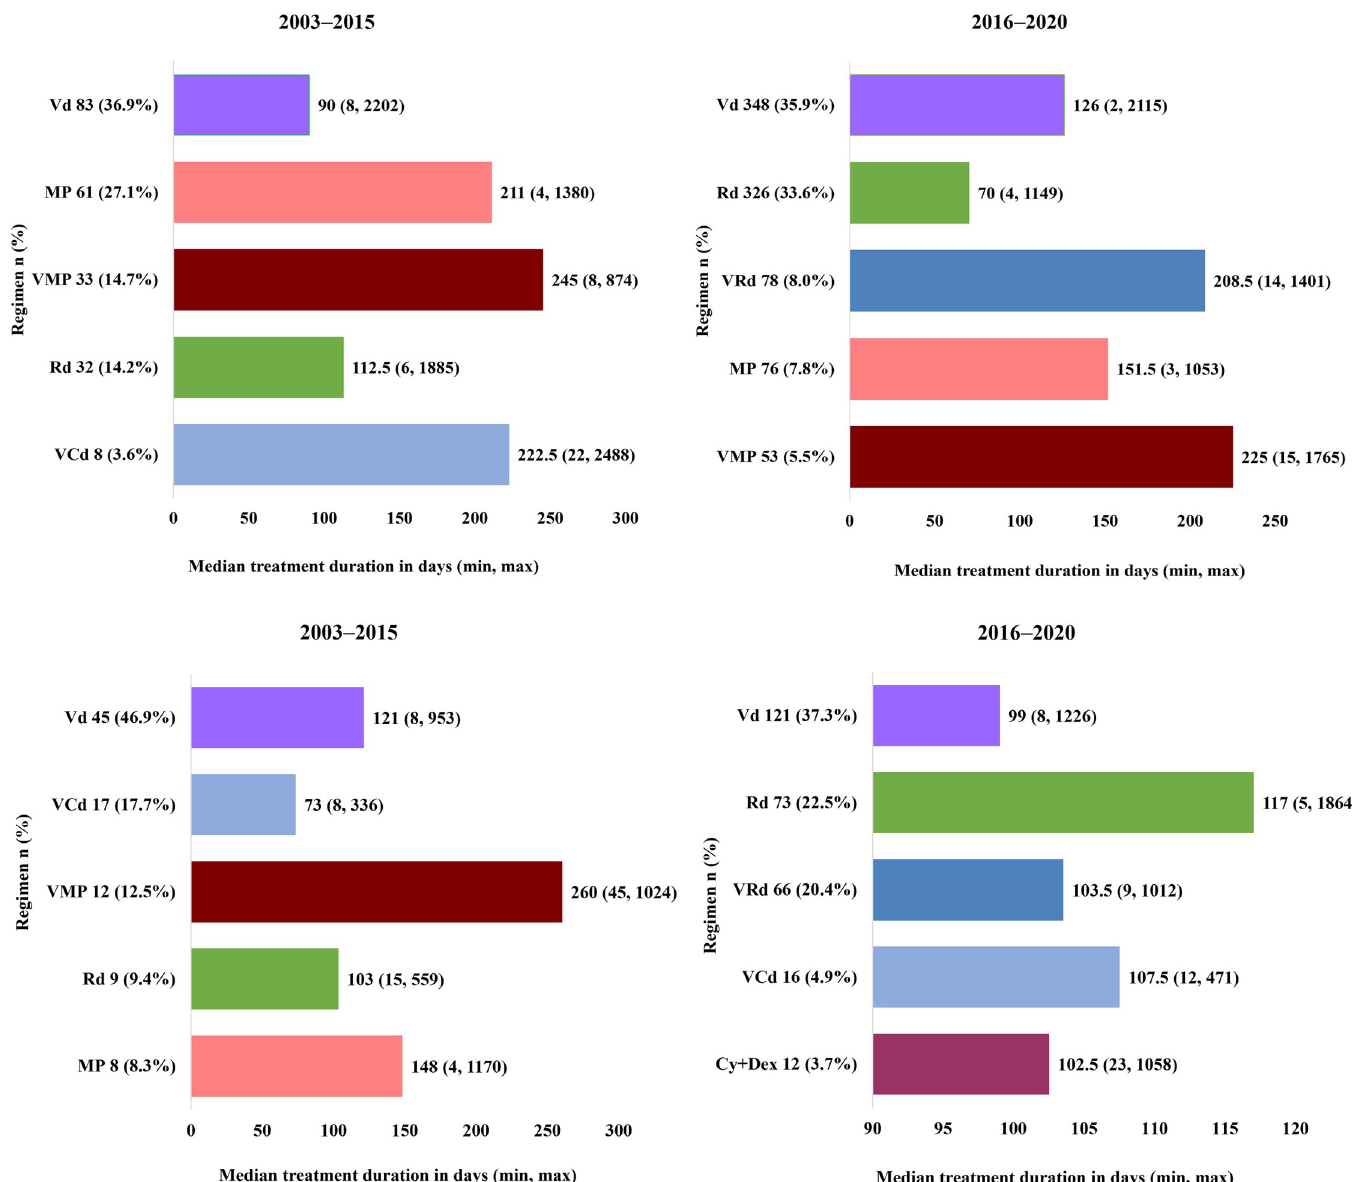
Fig 4. A : First-line treatment duration by selected regimen in SCT not-conducted group (aged > 70 years). B : First-line treatment duration by selected regimen in SCT not-conducted group (aged � 70 years). Cy+Dex, cyclophosphamide/dexamethasone; MP, melphalan/prednisolone; Rd, lenalidomide/dexamethasone; VCd, bortezomib/ cyclophosphamide/dexamethasone; Vd, bortezomib/dexamethasone; VMP, bortezomib/melphalan/predonisolone; VRd, bortezomib/lenalidomide/dexamethasone. Note: Top 5 regimens in the proportion of use were selected.